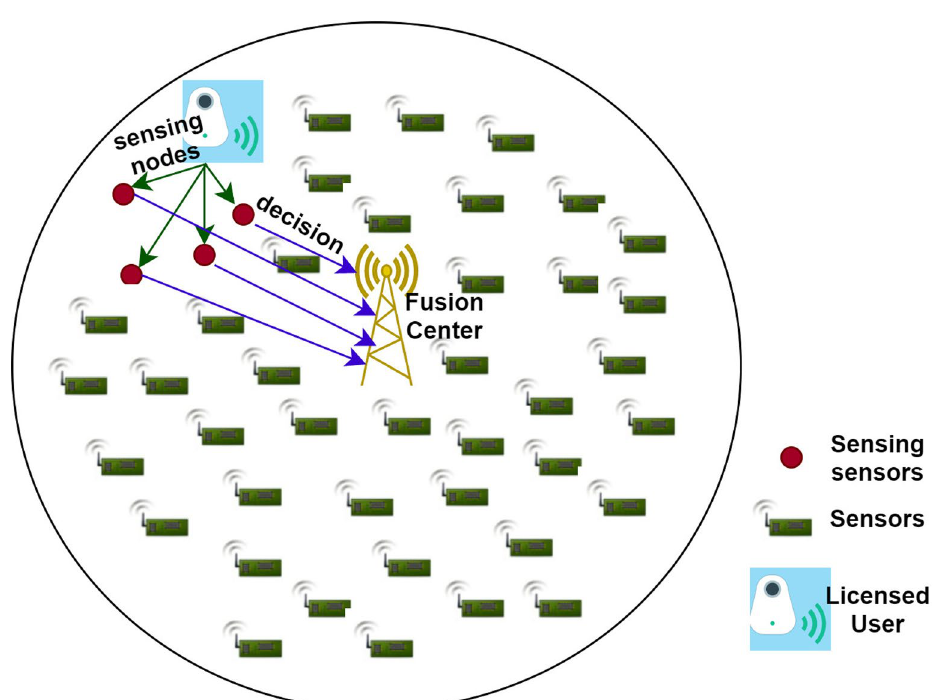
Figure 3. Cooperative spectrum sensing for smart